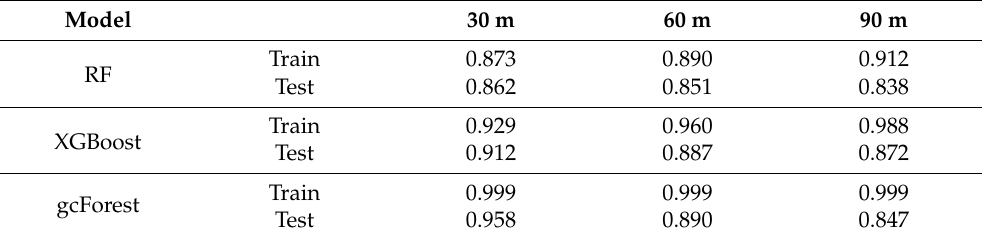
Table 6. Accuracies of the models with different grid sizes for training data and test data.